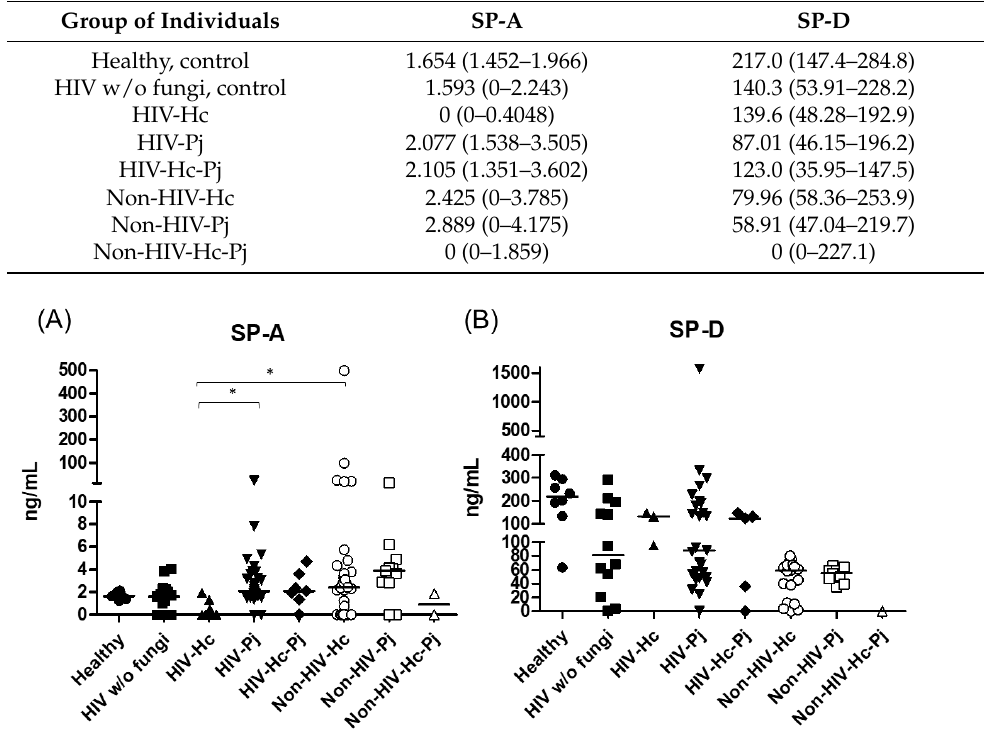
Streptococcus pneumoniae . Table 2. Detection of SP-A and SP-D. Median values for all group determinations are shown in ng/mL, followed by their corresponding 25–75 interquartile range in parenthesis. Abbreviations of each group of individuals are the same in all figures. The presence of SP-A and SP-D was determined by separate BioAssay ELISA Kits in BAL samples of hospitalized patients (details in the Section 2).